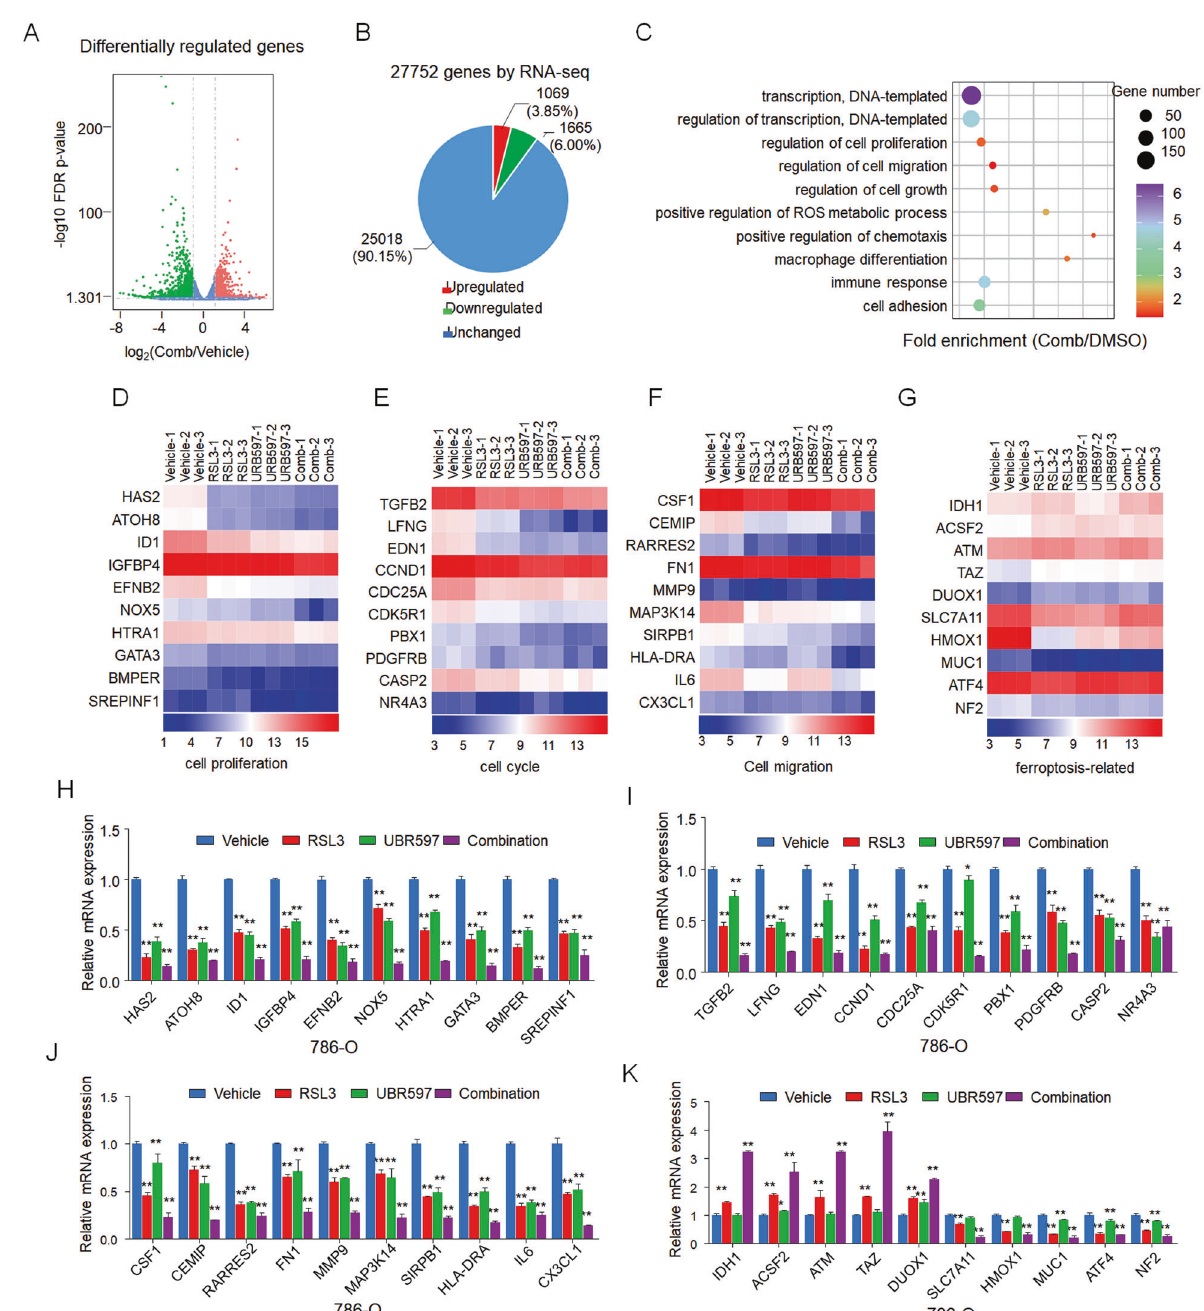
Fig. 5 RNA-Seq reveals that the combination of URB597 and RSL3 regulates the expression of genes related to cell growth and metastasis. A, B Volcano plot of the results of an RNA-Seq analysis showing the expression of differentially regulated genes in 786-O cells between the control vehicle and combinational treatment (Comb) with URB597 (10 µM) and RSL3 (0.5 µM). Upregulated and downregulated genes are shown in red and green, respectively. Values are presented as the log10 of tag counts. C KEGG pathway analysis of differentially expressed genes in transcriptomes of 786-O cells between the control vehicle and combinational treatment (Comb) with URB597 (10 µM) and RSL3 (0.5 µM). The 10 most signi fi cantly activated pathways are shown. Heat map of signi fi cantly regulated genes in transcriptomes of 786-O cells between the control vehicle and combinational treatment (Comb) with URB597 (10 µM) and RSL3 (0.5 µM) correlated with cell proliferation ( D ), the cell cycle ( E ), cell migration ( F ), and ferroptosis ( G ) ( n = 3). qPCR analysis of the indicated gene expression associated with cell proliferation ( H ), the cell cycle ( I ), cell migration ( J ), and ferroptosis ( K ) in 786-O cells treated with URB597 (10 µM) and RSL3 (0.5 µM) singly or in combination for 48 h compared to parental 786-O cells. Data are means ± SDs of measurements repeated three times with similar results. ns (not signi fi cant), ** p < 0.01 versus the corresponding control ( t